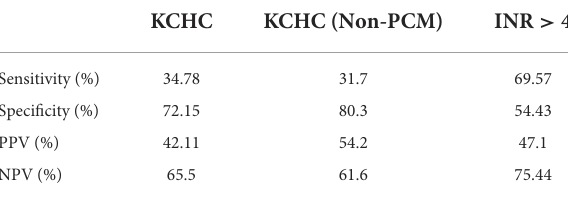
TABLE 3 Validity of liver transplantation